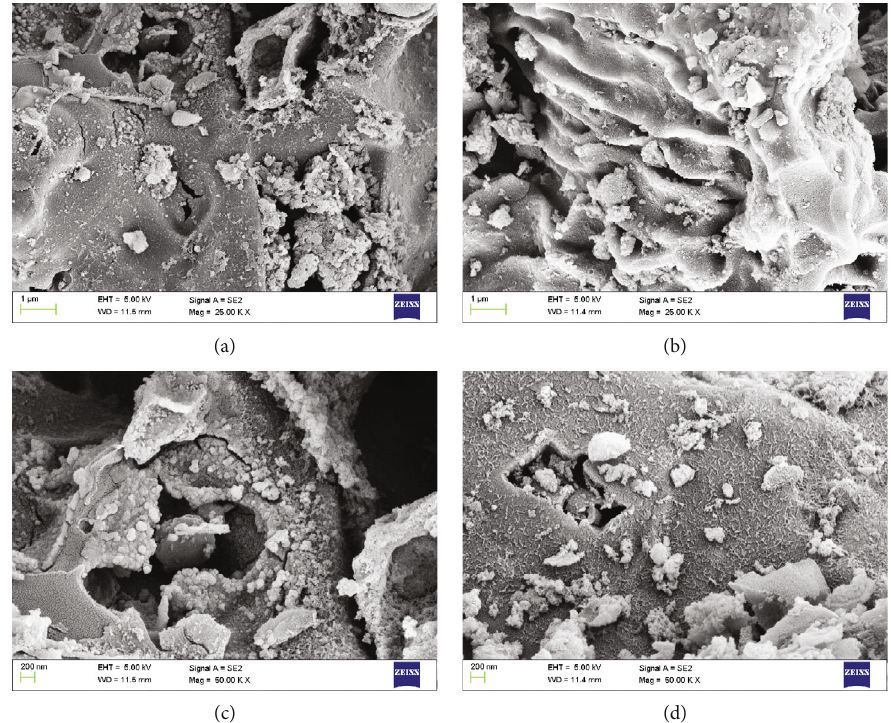
Figure 4: SEM images of the SpLAC sample at low magni fi cation (25.00 KX) and high magni fi cation (50.00 KX). (a, c) Fresh AC and (b, d) spent AC samples.